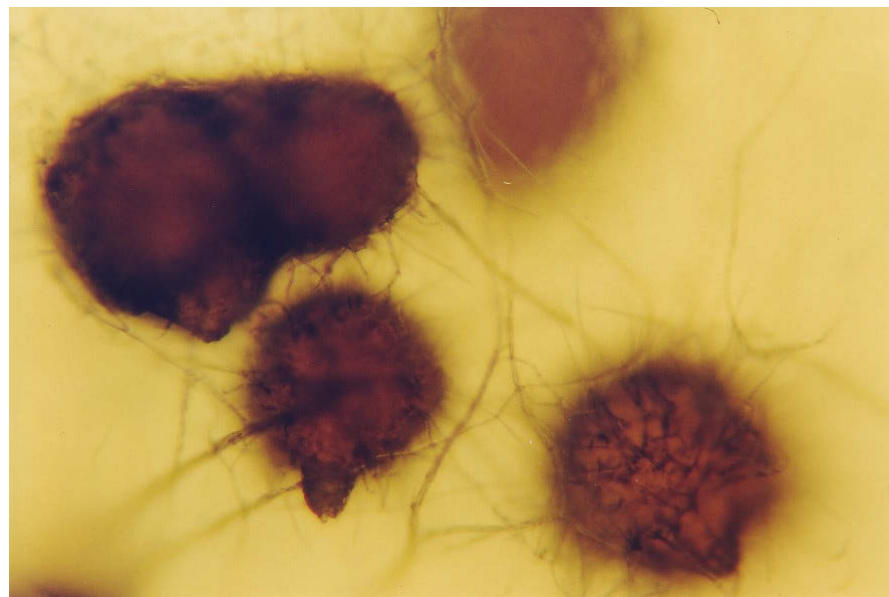
Fig. 2. Pycnidia of Phoma negriana , W 1075, 160 x magnification. Phot. E.